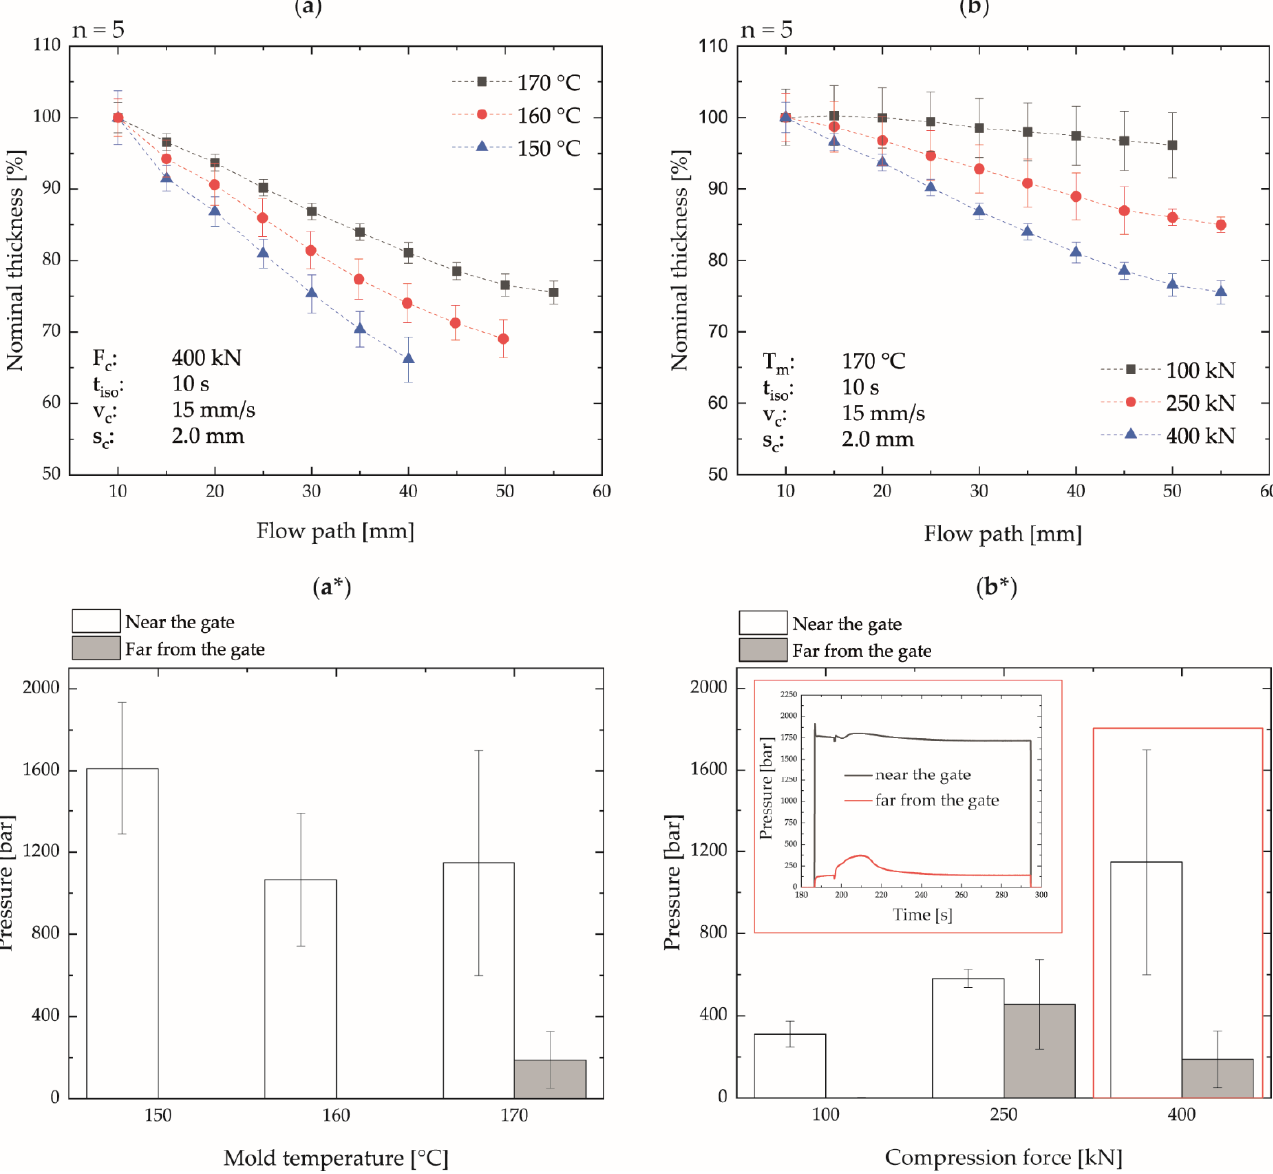
Figure 10. Nominal thickness dimensional stability over the flow path as a function of mold tem- perature ( a ) and compression force ( b ) as well as the associated maximum cavity pressures during compression at the positions near and far from the gate ( a* , b* ); abbreviations, see Table 2. The evaluation of the pressure signals in the mold at the positions near and far from the gate at the time of compression shows a significant pressure difference between the two measuring positions. This state is also persisted during the isobaric and isothermal holding phase and during the cooling phase, as shown in Figure 10a,b*. For this reason, the compression force instead of the pressure signal is depicted in Figure 10. Due to the